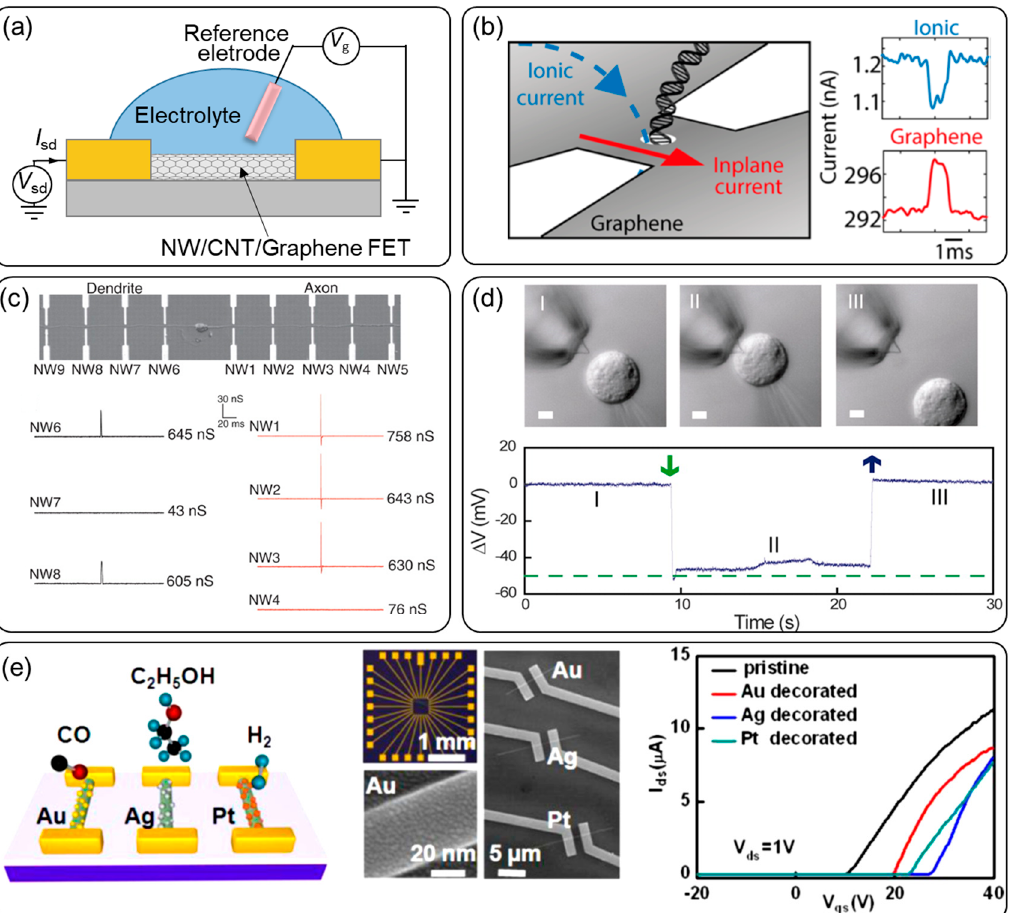
Figure 3. NanoFET configuration and applications: ( a ) schematic configuration of NanoFETs, ( b ) DNA translocation event detection with a graphene nanoribbon and a nanopore simultaneously [62], ( c ) extracellular neuronal signal detection with high-density nanowire arrays [64], ( d ) intracellular potentials recording with a Si NWs [65], ( e ) Si NW arrays for gas composition sensing [67].